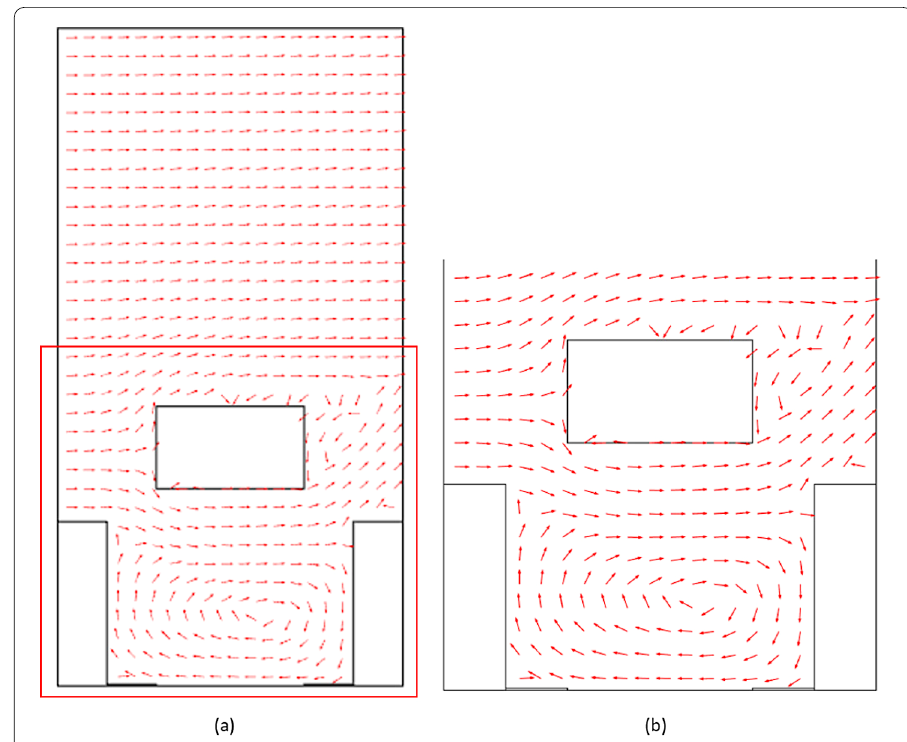
Figure 10 The velocity vector (km/h) at steady state when u = 7 km/h (gentle wind): ( a ) Half of the entire computational domain, and ( b ) Zoom-in of the selected